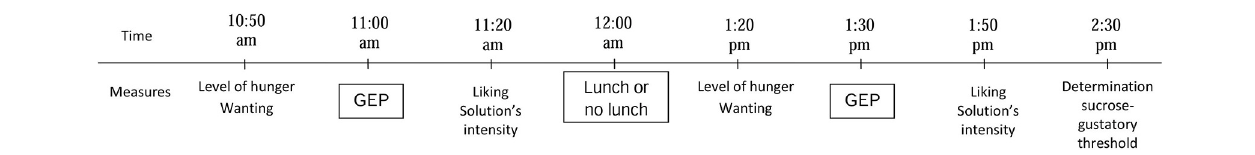
Frontiers in Neuroscience |